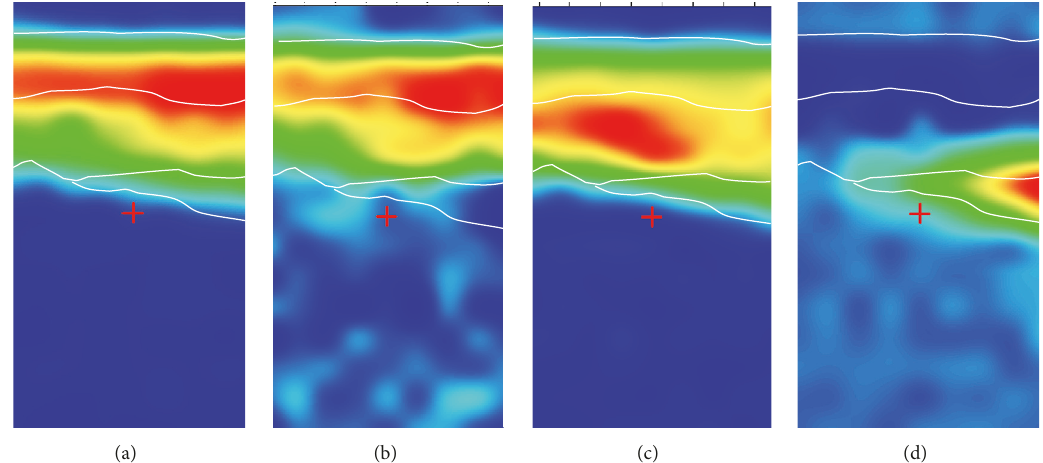
Figure4:Sample15r1.Univariatechemicalmapsobtainedbyintegrationoftheabsorptionbandat(a)1600cm −1 ;(b)2928cm −1 ;(c)1030cm −1 ; (d) 1155cm −1 .